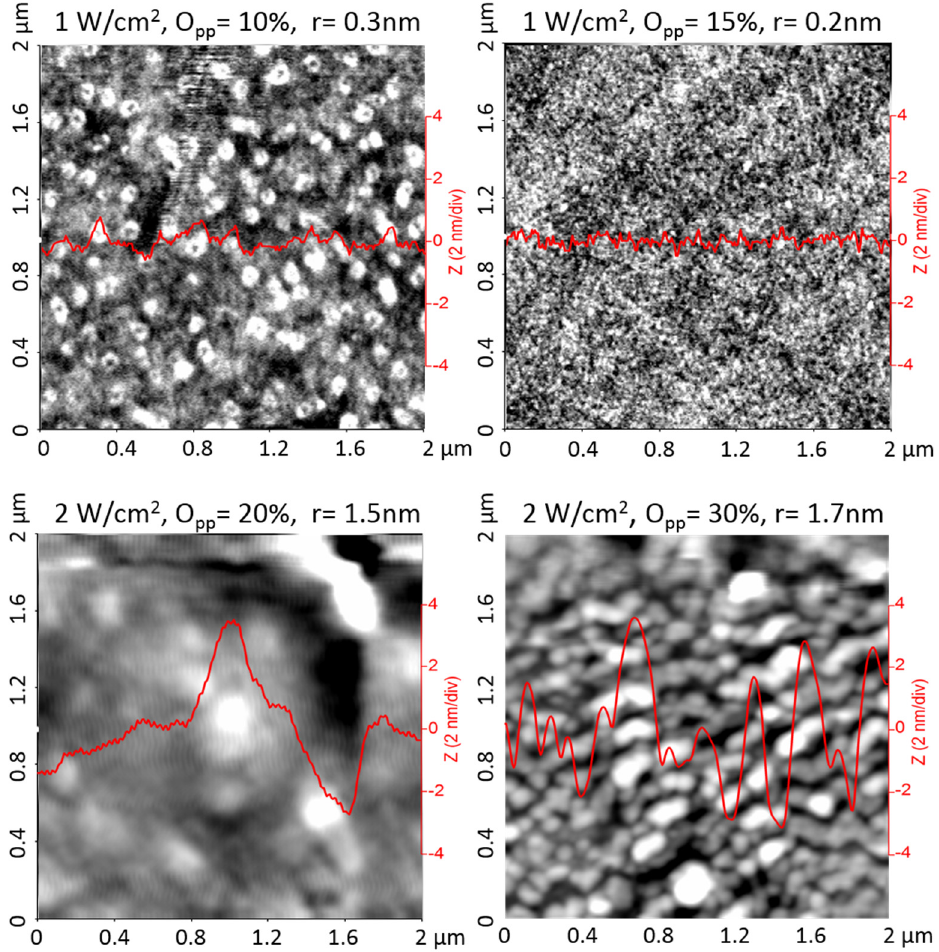
Figure 3. AFM images and representative line scans taken on the surface of WO 3 − x layers prepared at different sputtering powers and oxygen partial pressures. The root-mean-square roughness value (r) is included for each sample.